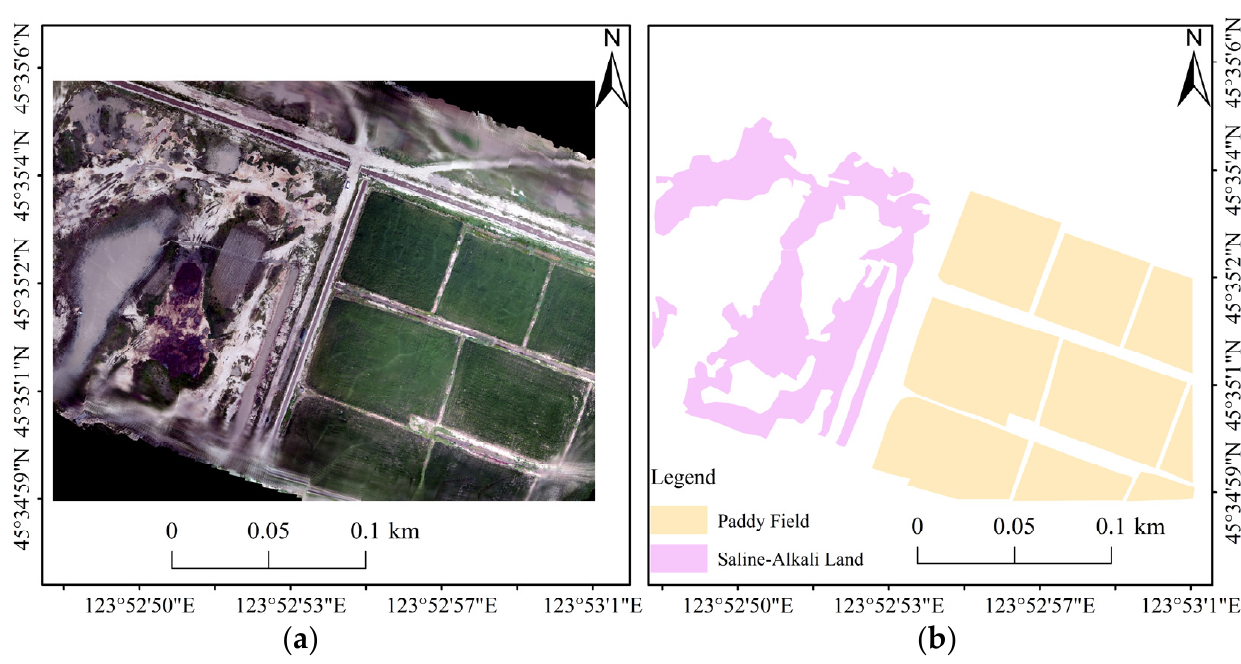
Figure A1. UAV visible light image in the typical area ( a ) and spatial distribution of saline–alkali land and paddy fields ( b ).